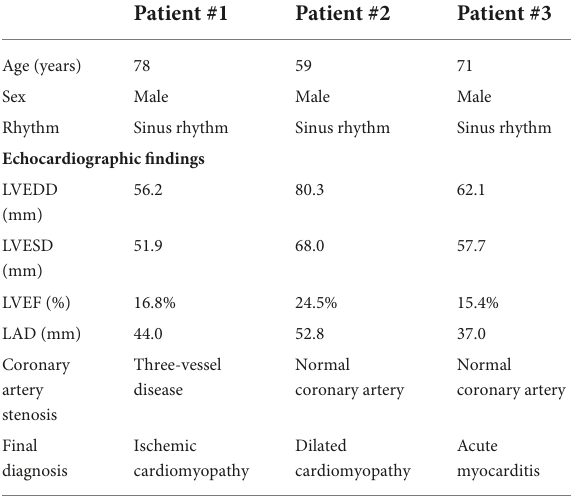
TABLE 1 Clinical characteristics of the three heart failure patients who received endomyocardial